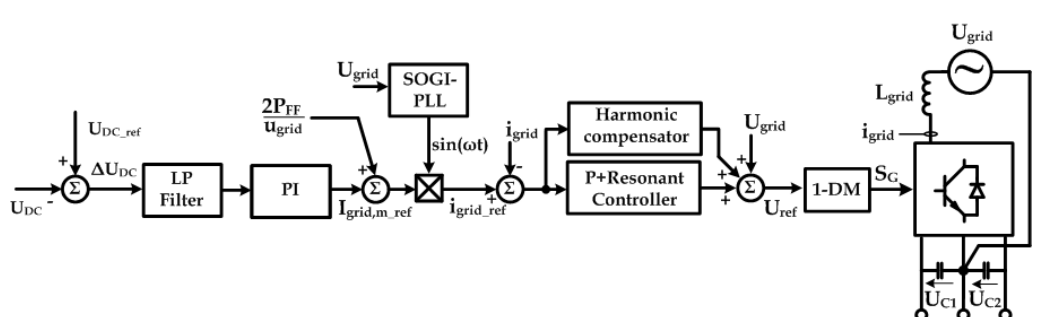
Fig. 4. Single-phase DC/AC converter control scheme.